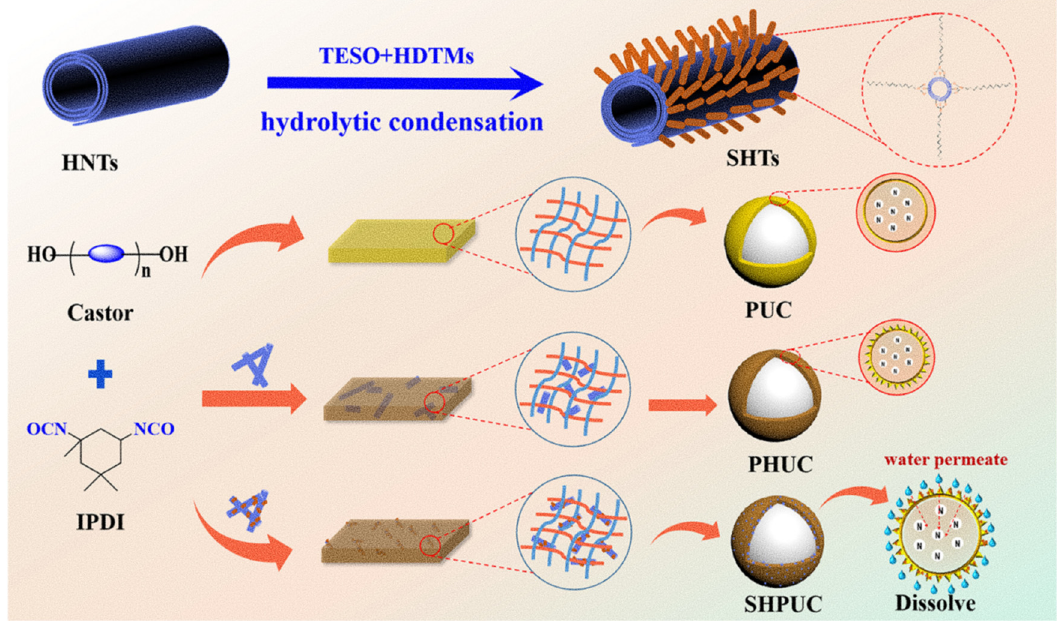
Figure 12: Diagrammatic representation of the various coating modi fi cations employed in the biobased coated CRF [ 160 ] . Copyright 2022, Elsevier Science